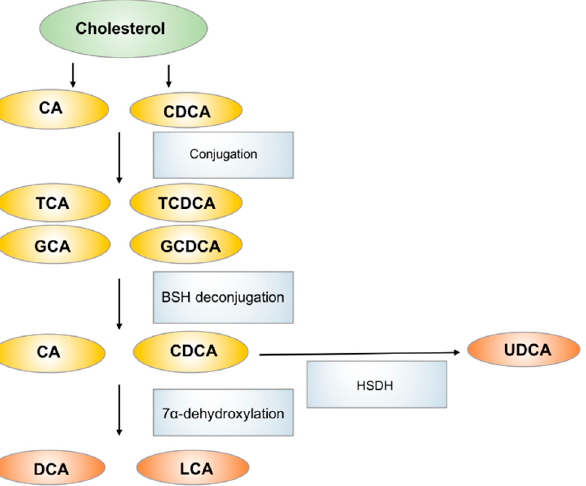
Figure 3. The biosynthesis and metabolism of bile acids in human. CA: cholic acid, CDCA: che- nodeoxycholic acid, TCA: taurocholic acid, GCA: glycocholic acid, TCDCA: taurochenodeoxycholic acid, GCDCA: glycochenodeoxycholic acid, DCA: deoxycholic acid, LCA: lithicholic acid, UDCA: ursodeoxycholic acid.